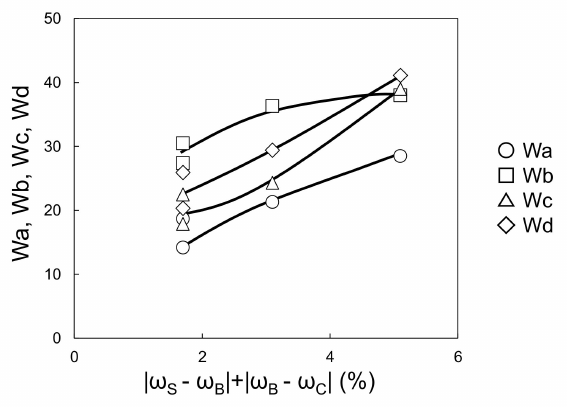
Figure 12. Relationship between | ω S − ω B | + | ω B − ω C | and Wa–Wd (changing melamine resin content in waterborne basecoat).